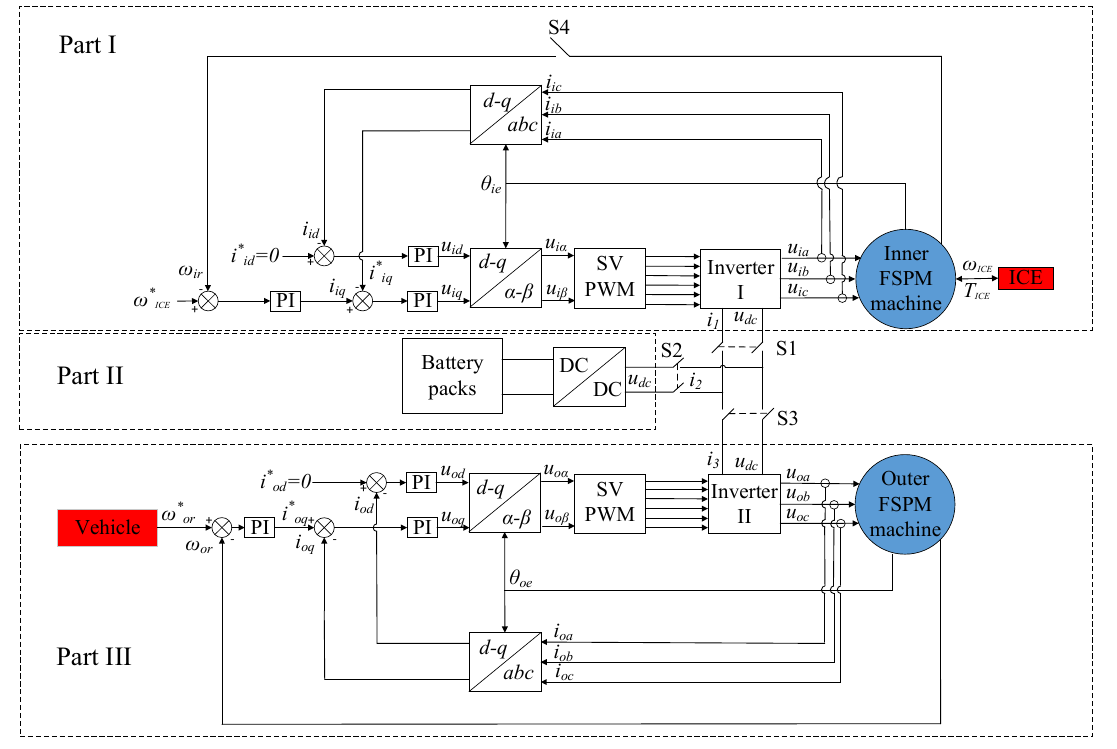
Figure 3. The control system of the proposed CADMP ‐ FSPM machine ‐ based E ‐ CVT system.